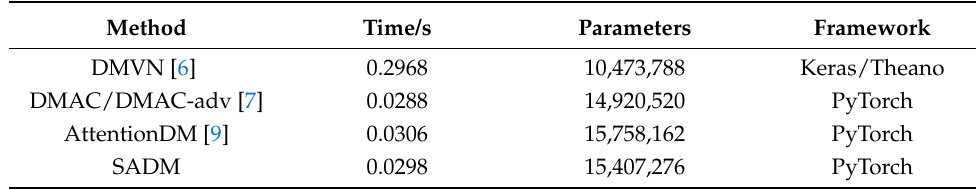
Table 4. Time complexity